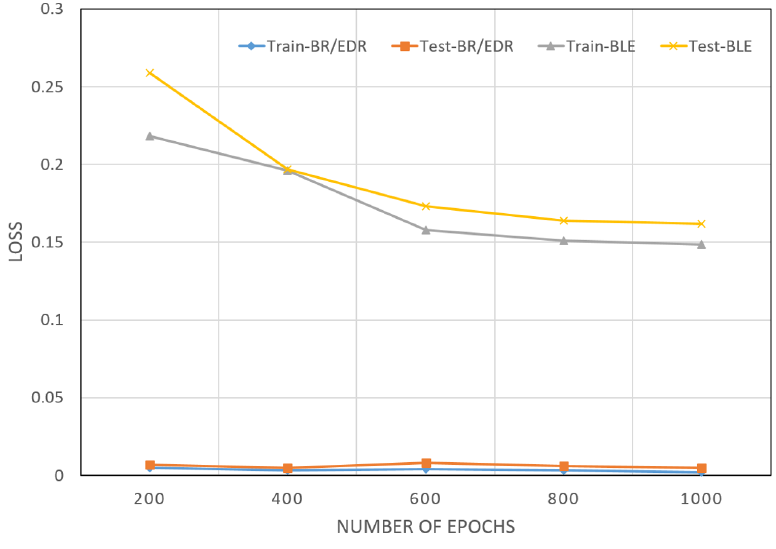
Figure 10. Training and testing loss–DNN. The recorded test was a loss of 0.01, which indicated that DNN was reliable for the real-time application, Table 10. Performance analysis of the binary and multi-class classification of the proposed IDS (BR/EDR and